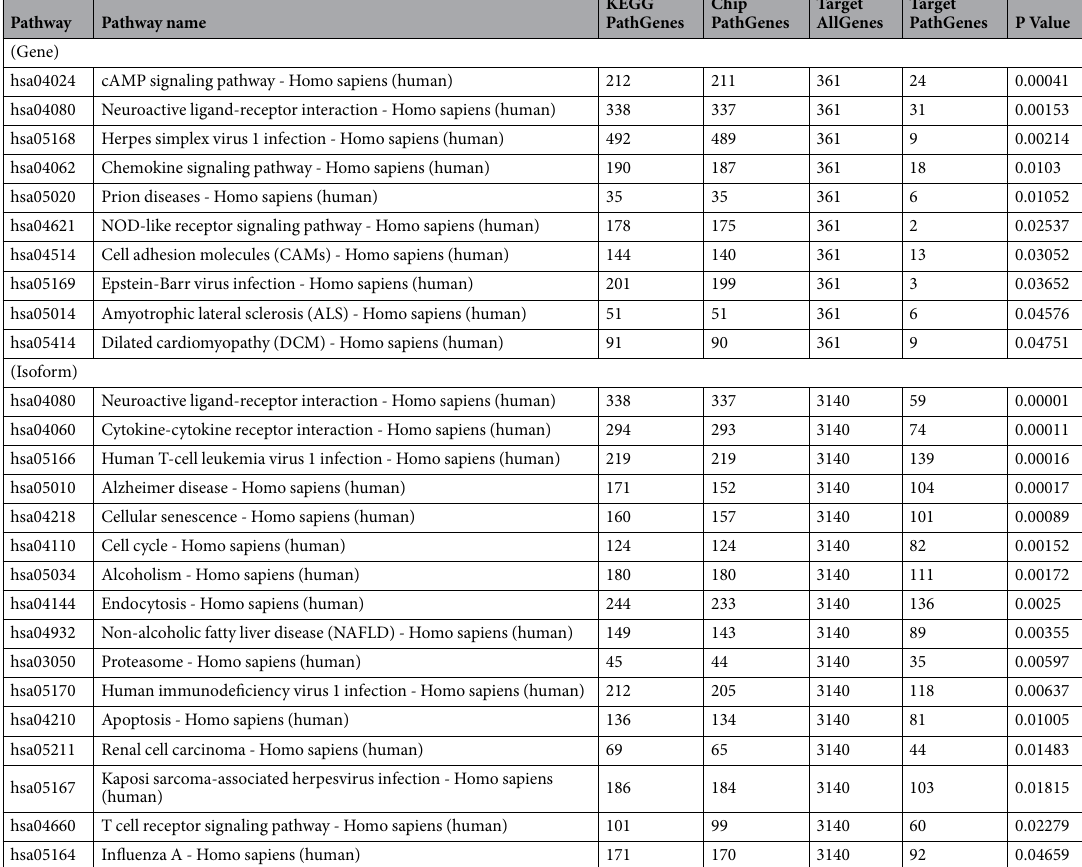
Table 3. The target pathway candidates in